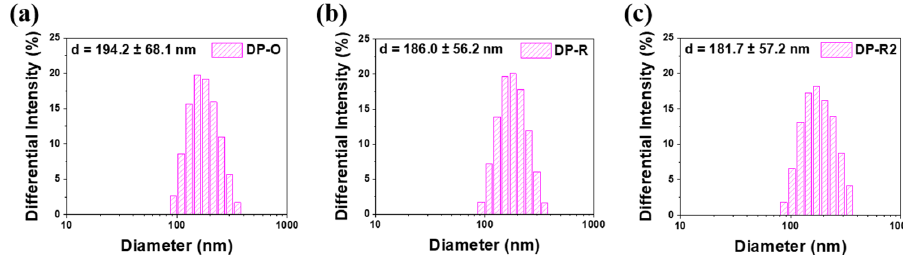
Figure 6. Size distribution of DPP ‐ based AIE NPs using DLS. ( a ) DP ‐ O, ( b ) DP ‐ R, ( c ) DP ‐ R2.